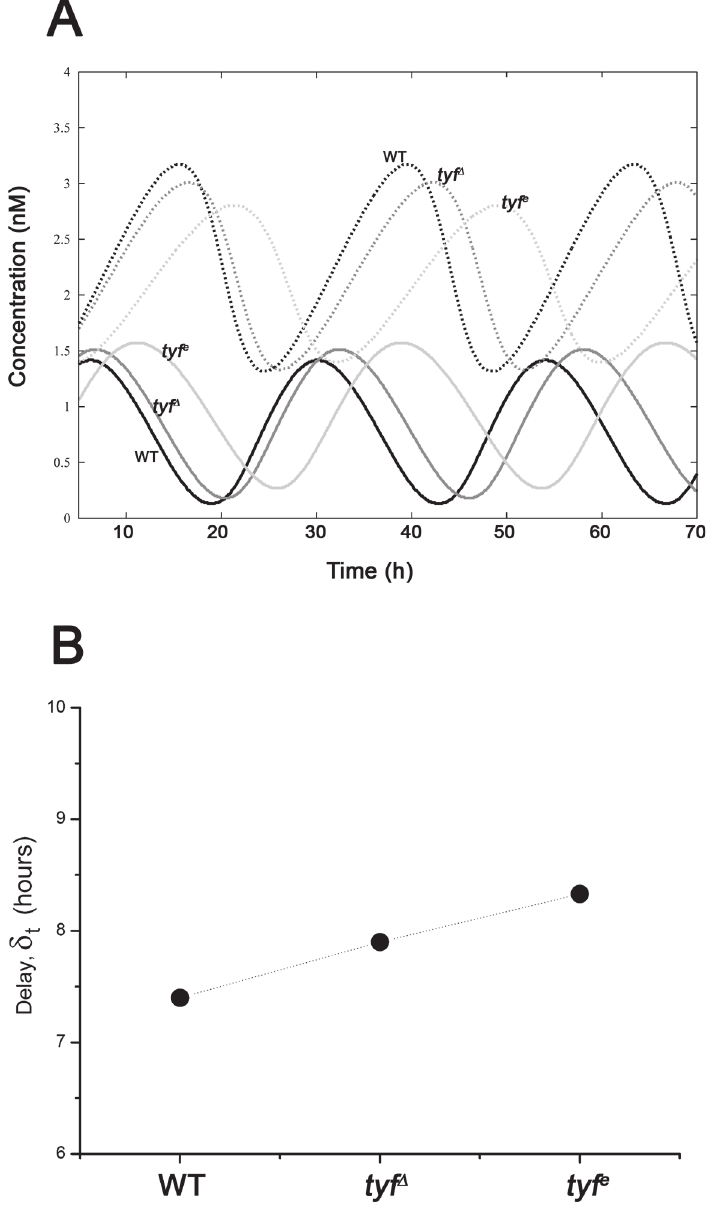
Figure 8. Circadian oscillations and delays in WT and tyf mutant flies. (A) Time evolution of the per transcript ( solid lines ) and total PER protein ( dashed lines ) in WT ( black ), tyf Δ ( dark gray ) and tyf e ( light gray ) flies. (B) Delay values ( δ t ) of each fly strain. Results obtained with our model for k s = 0 h − 1 , K r = 0.3 nM h − 1 and nH = 4. Dotted line was plotted only for clarity purposes. See the text for further